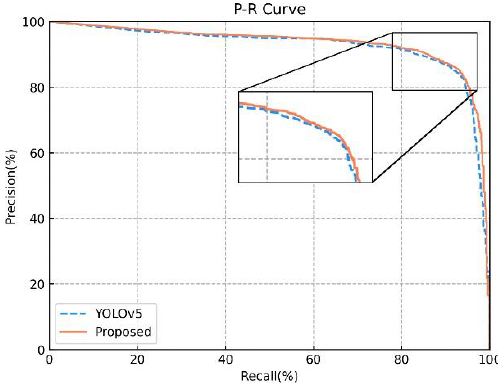
Figure 11. P-R Curve on the HRSC2016 dataset.